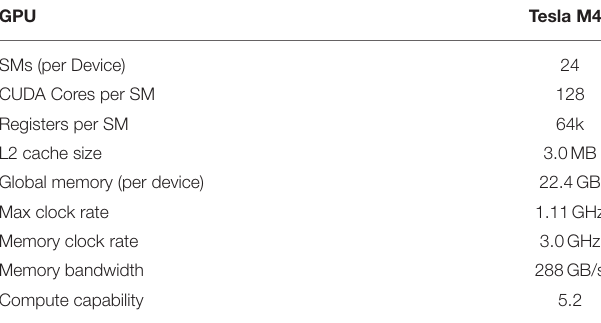
TABLE 2 | Summary of NVIDIA Tesla M40 GPU